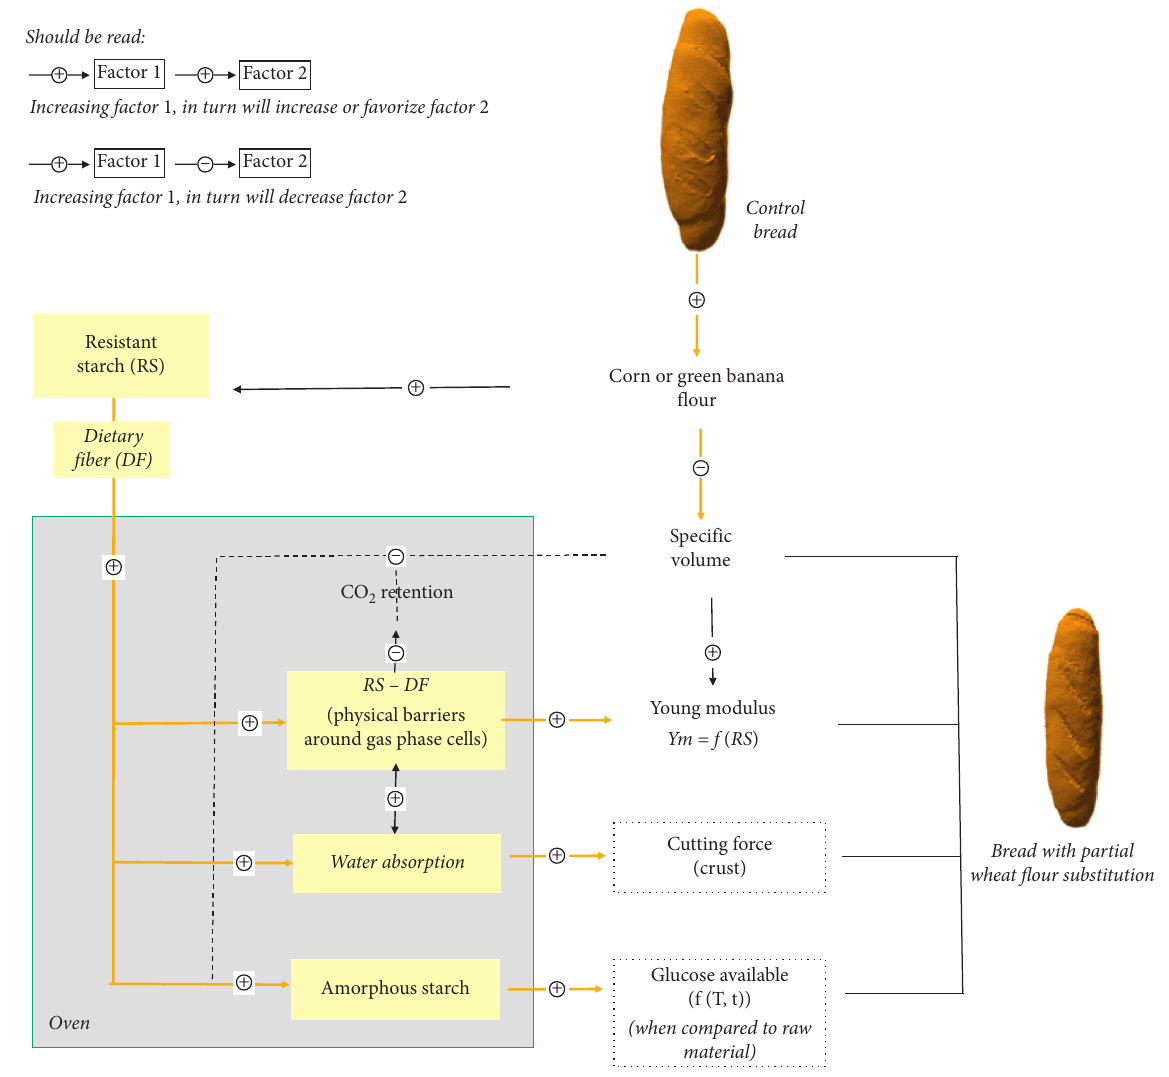
Figure 2: Flow chart to identify the macroscopic and macromolecular changes in structural, physical, and texture properties of enriched resistant starch composite bread produced with partial wheat flour substitution and its